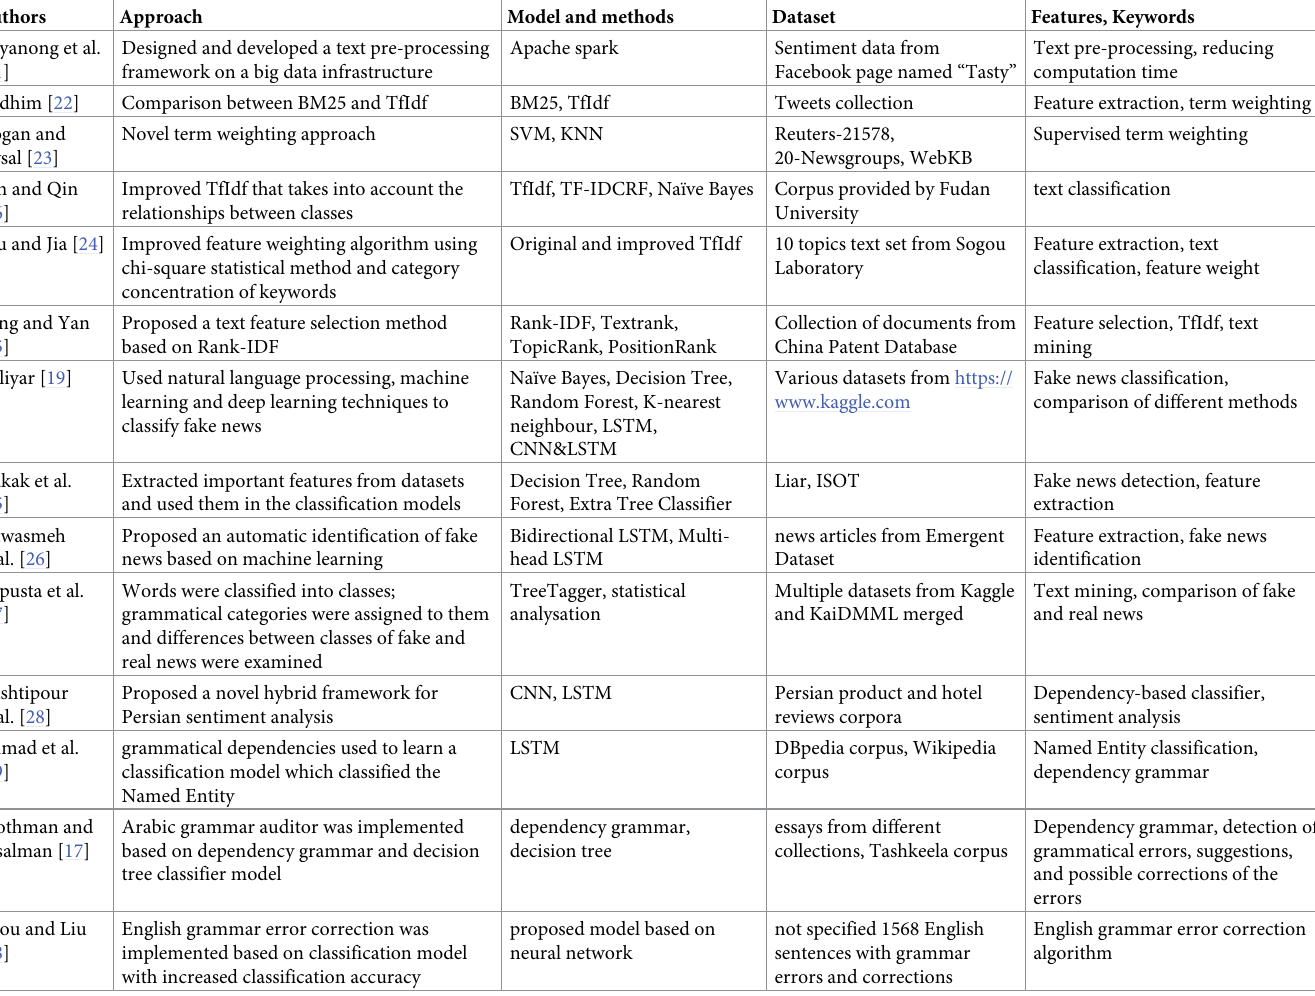
Table 1. Summarization of research